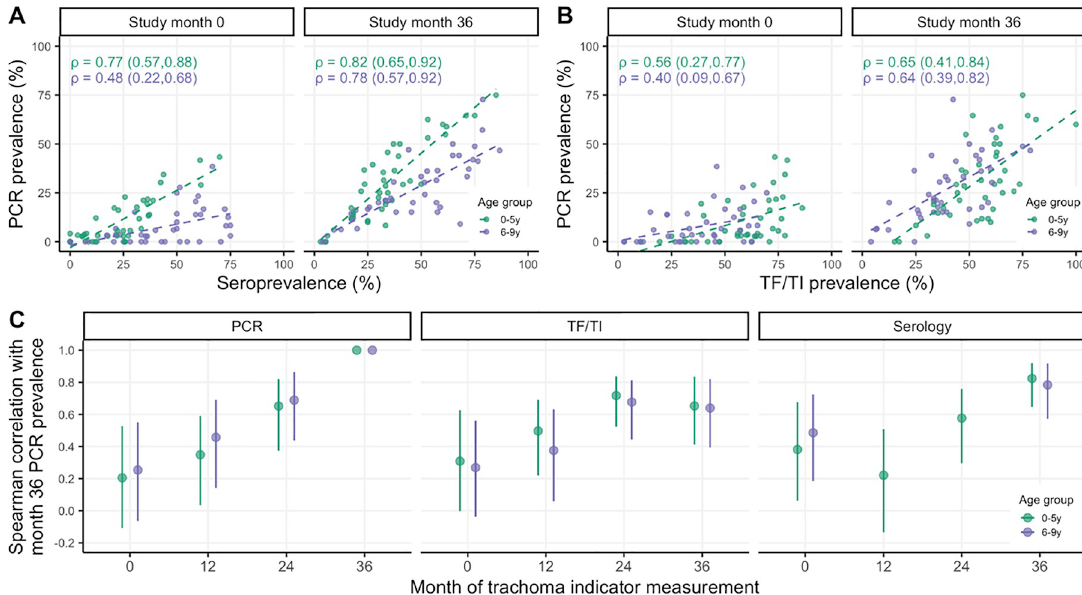
Fig 3. Correlations between trachoma indicators by age group and over time. Panels display Spearman rank correlations between community-level seroprevalence and PCR prevalence at study months 0 and 36 (A), active trachoma prevalence and PCR prevalence at months 0 and 36 (B), and PCR prevalence at month 36 and trachoma indicators measured at each survey across 40 study communities (C). Correlations are shown separately for 0–5-year-olds (green) and 6–9-year-olds (purple), and 95% confidence intervals were estimated from 1000 bootstrap samples. Serology data were not collected for a random sample of 6–9-year-olds at months 12 and